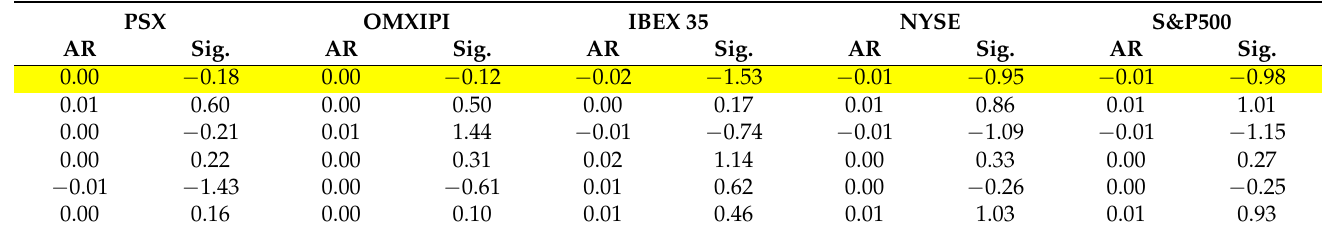
Table A14. Abnormal returns of the (0, +5) event window (Prime Minister of Iceland announced his resignation).